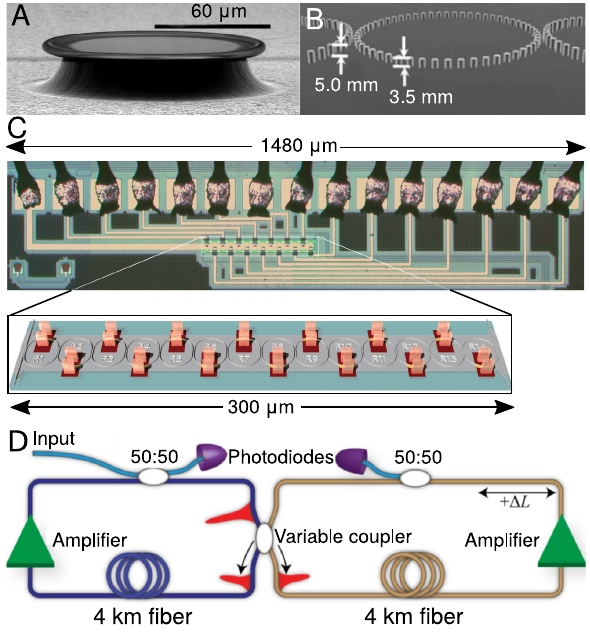
Figure 2: Examples of ring resonators in different platforms. (A)